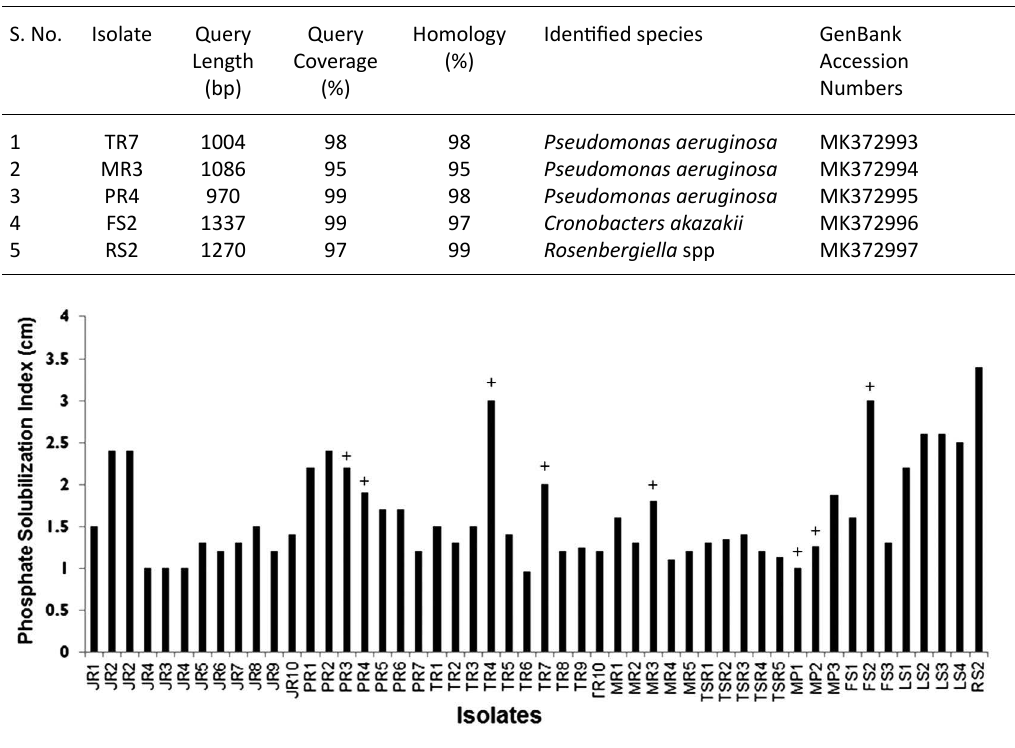
of selected 14 isolates were deciphered (Table 2). Table 3. Molecular characterization of five selected isolates S.